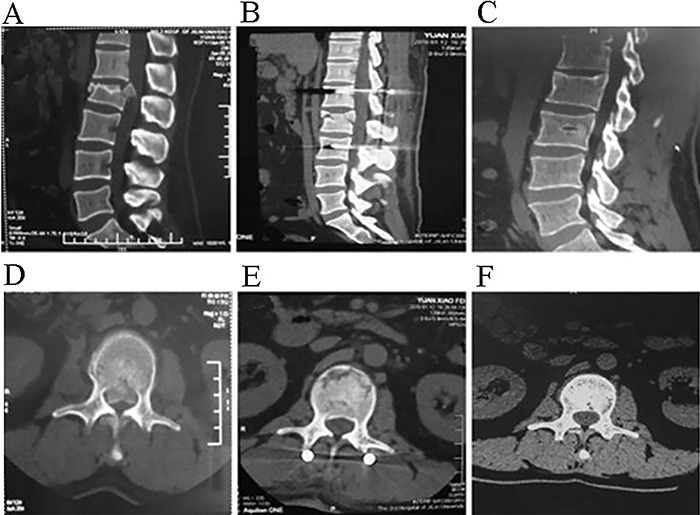
CT images showing significant restoration of the posterior and anterior
vertebral height after surgery (B) and 2 years postoperatively
(C), compared with the preoperative image
(A). Postoperative axial CT image (E) showing
significant canal decompression compared with the preoperative image
(D). F, postoperative image two years after
surgery showing that the canal was still enlarged.